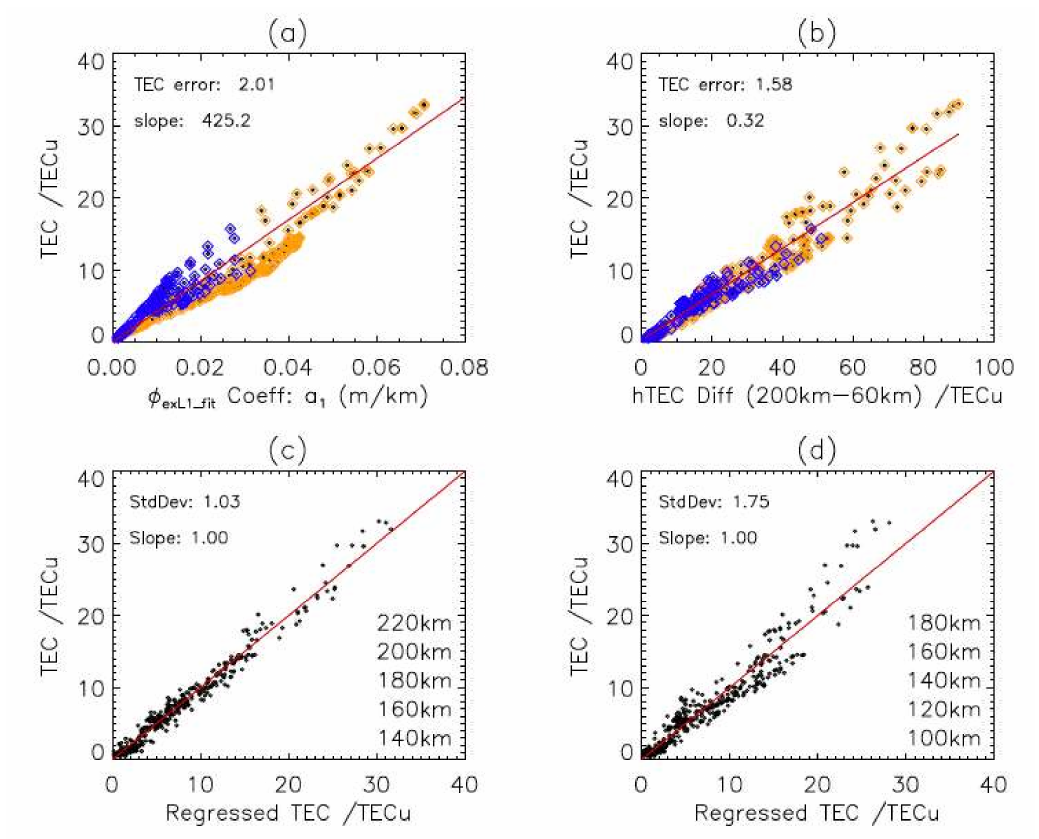
Figure 7. Simulated TEC relationships with ( a ) coefficient a 1 in Equation (8), ( b ) hTEC difference between h t = 200 km and h t = 60 km, ( c ) TEC values regressed from the hTEC differences at five levels between 140–220 km, and ( d ) TEC values regressed from five levels between 100–180